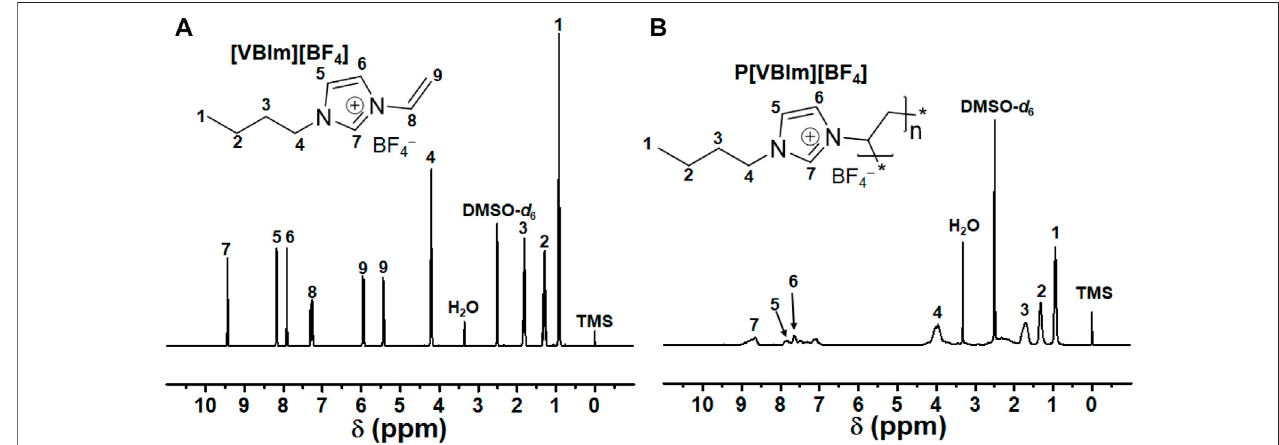
FIGURE 1 | 1 H-NMR spectra of IL monomer ([VBIm][BF4]) (A) and PIL (P[VBIm][BF4]) (B) .